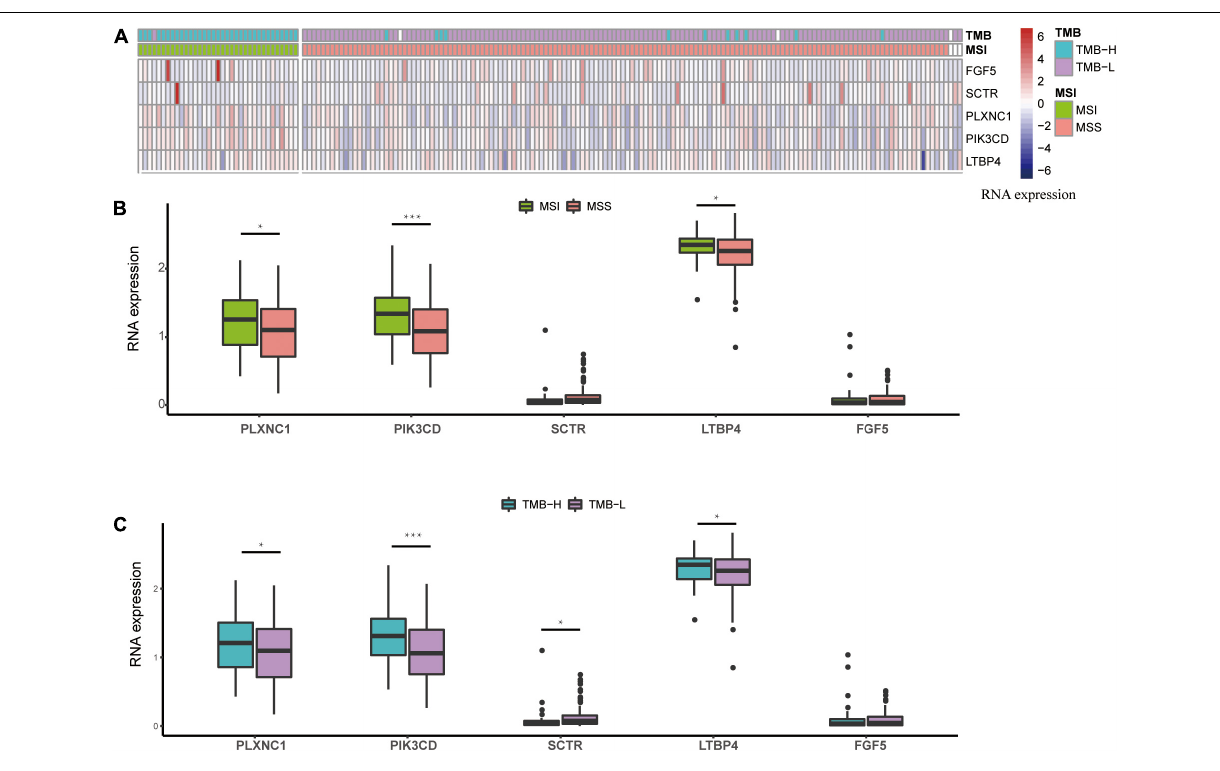
( Supplementary Figure 7 ). We built a gene model based on CG Score (New CG Score = CG Score ∗ correlation between gene expression and methylated sites) to assist in verifying the